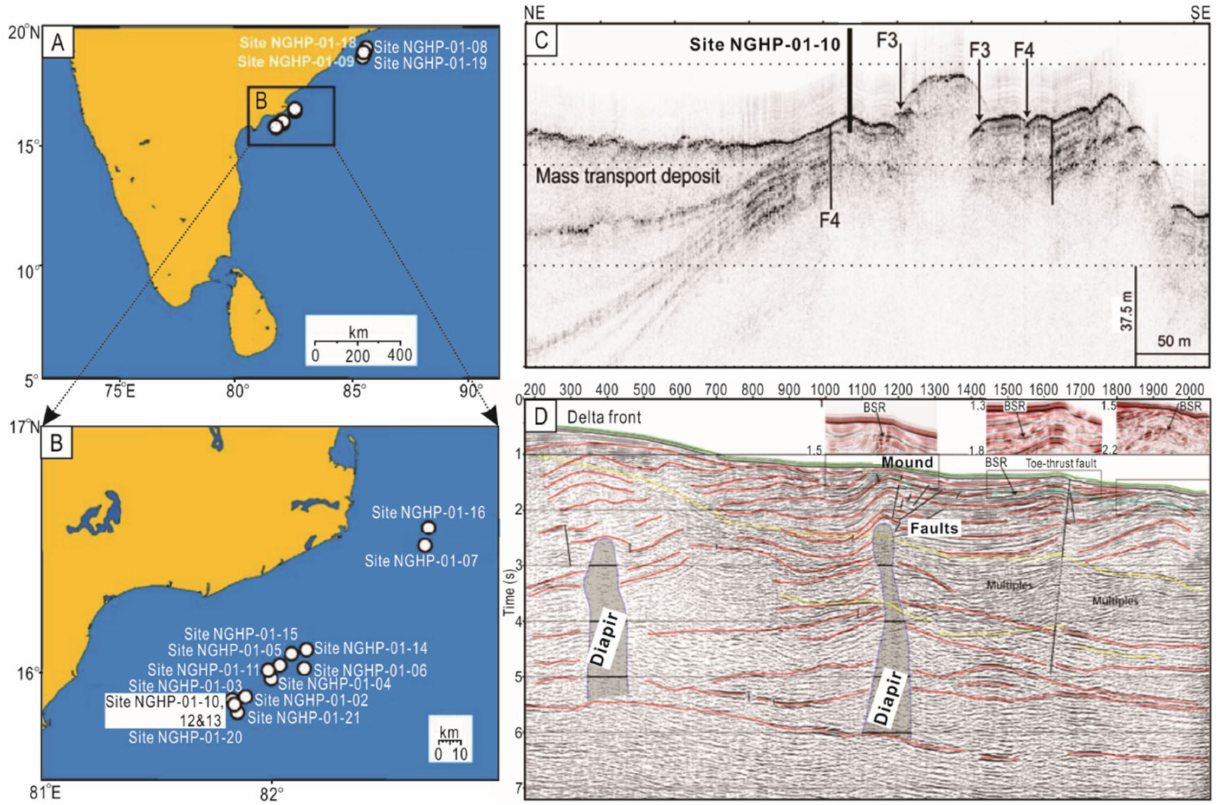
Figure 12. ( A ) NGHP-01 site map showing a portion of the drill site locations. ( B ) Inset map of the drill sites in KG Basin offshore India. ( C ) Central portion of the bathymetric mounds located close to NGHP-01-10. ( D ) Multichannel seismic profile showing diapir structures and related faults beneath the mounds. ( A and B are modified from [68]; C is cited from [71]; and D is cited from